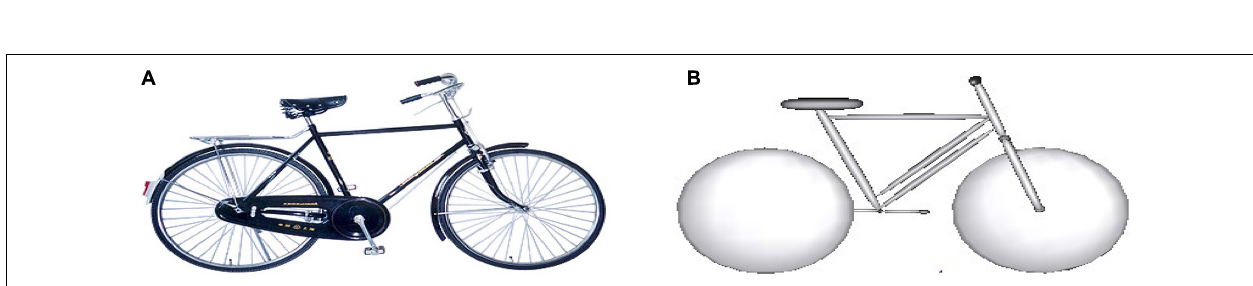
FIGURE 3 | Modeling of the bicycle involved in Case 21: (A) the bicycle in the real-world accident; and (B) MB model of the bicycle. MB, multibody.